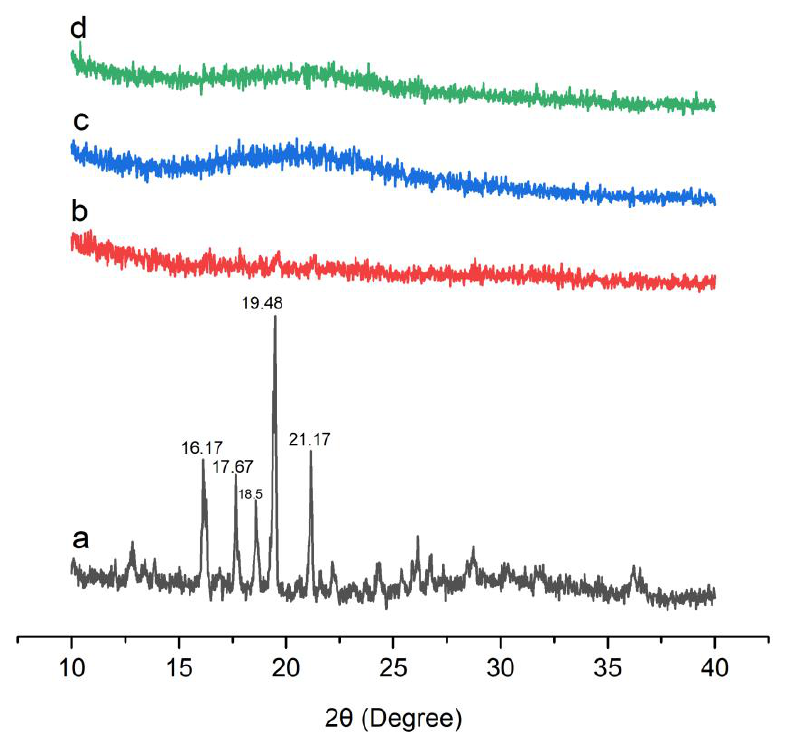
Figure 3. XRD graphs of ( a ) Dex, ( b ) S1, ( c ) S18, and ( d ) S23.